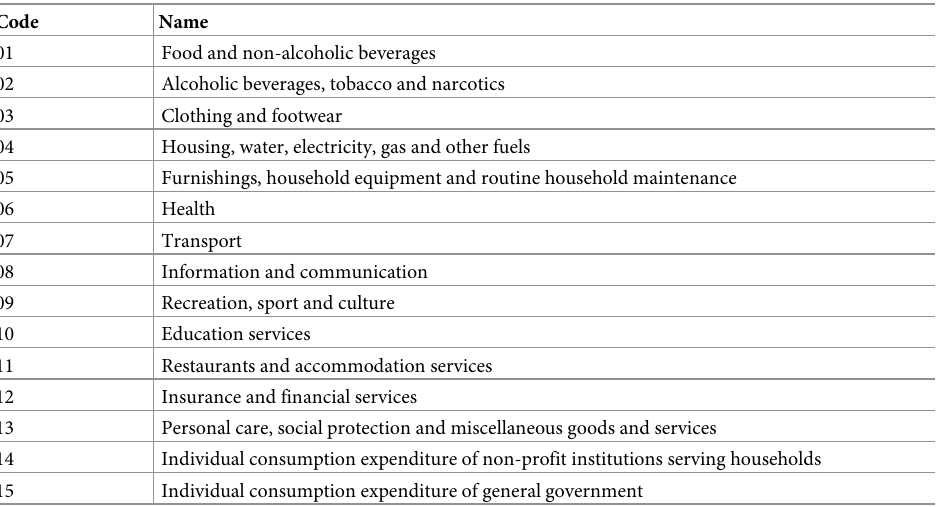
Table 2. Classification of Individual Consumption According to Purpose